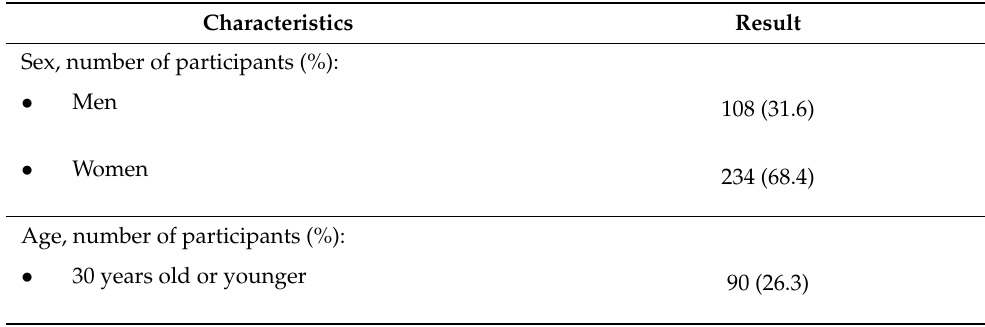
Table 1. Patients’